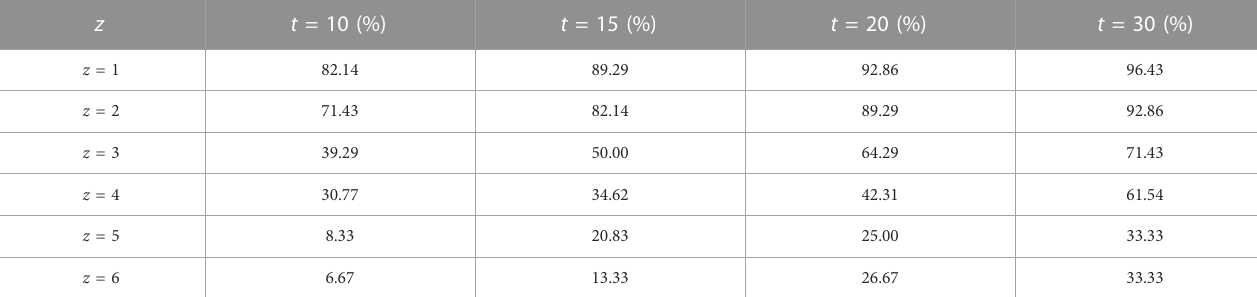
TABLE 6 Accuracy 4 ( t ) of testing set prediction.